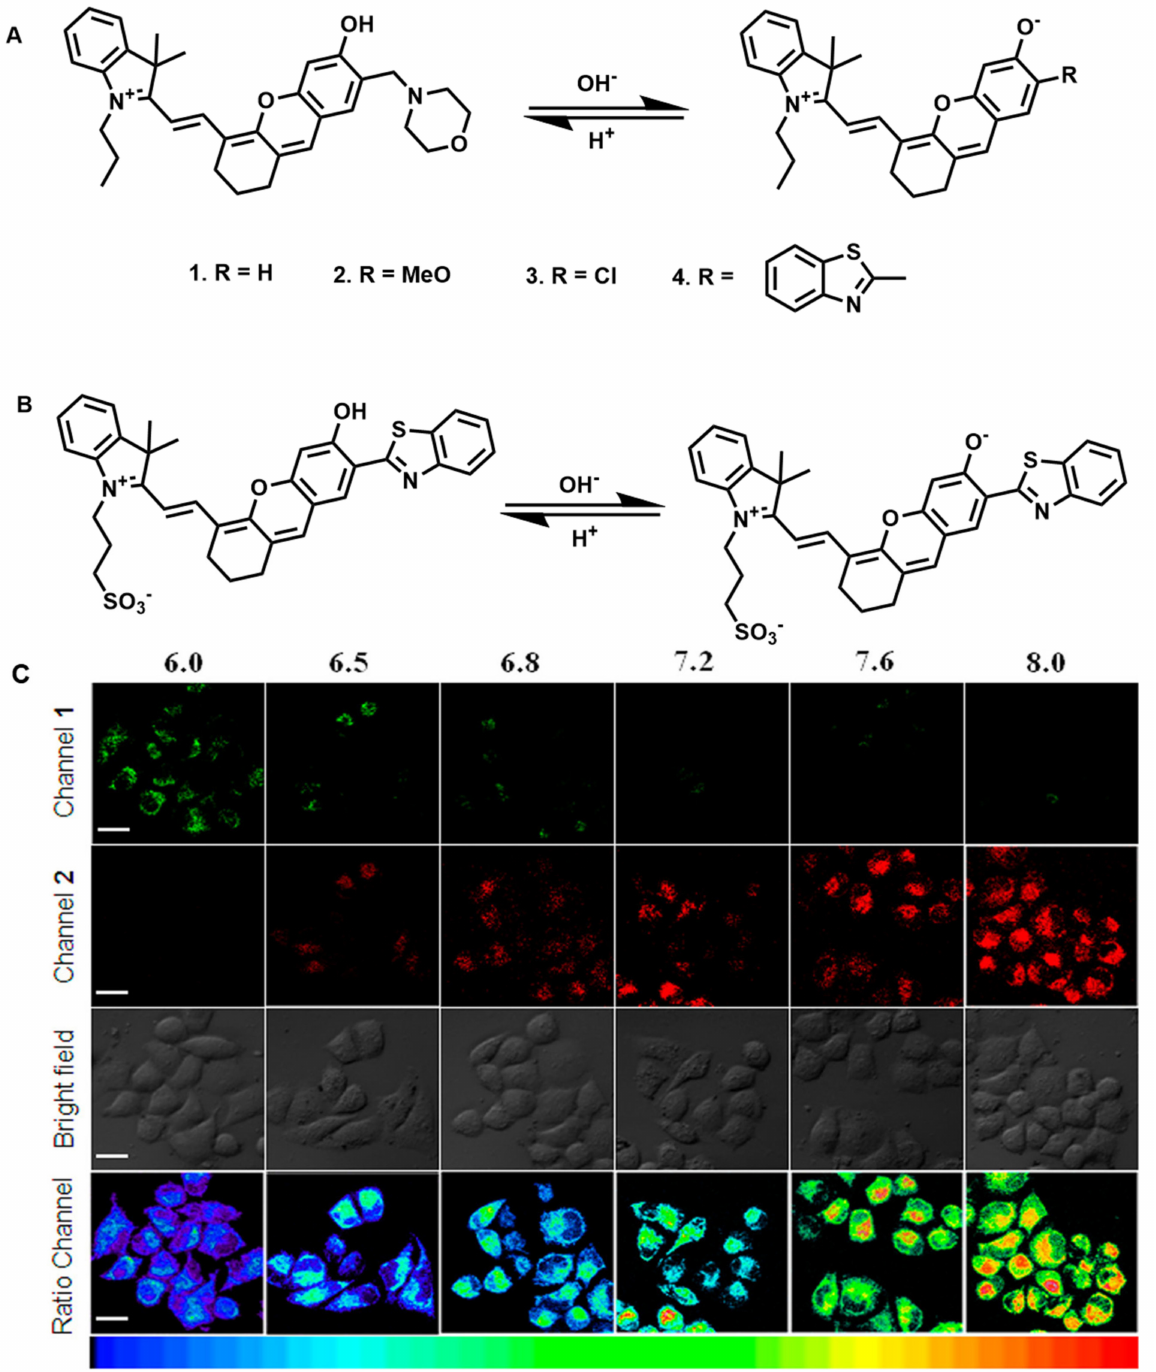
Figure 3. Responsive mechanism for pH and structures ( A , B ). ( C ) Fluorescent images in HeLa cells clamped at pH 6.0, 6.5, 6.8, 7.2, 7.6, and 8.0, respectively. Reproduced with permission from Ref. [49]. Copyright (2015) American Chemical